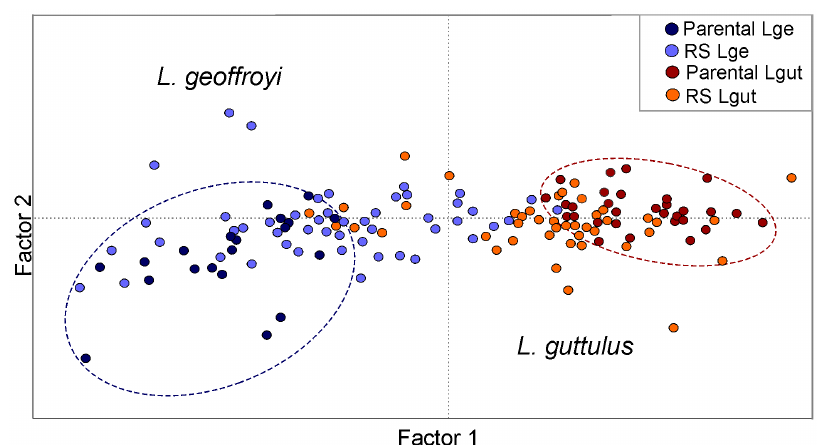
Figure 2. Factorial Correspondence Analysis (FCA) of autosomal microsatellite data. The graph shows the individual scores for parental and hybridizing populations of Leopardus guttulus and L. geoffroyi on the first two factor axes. Parental populations are delimited by circles ( L. guttulus – dark red; L. geoffroyi – dark blue).